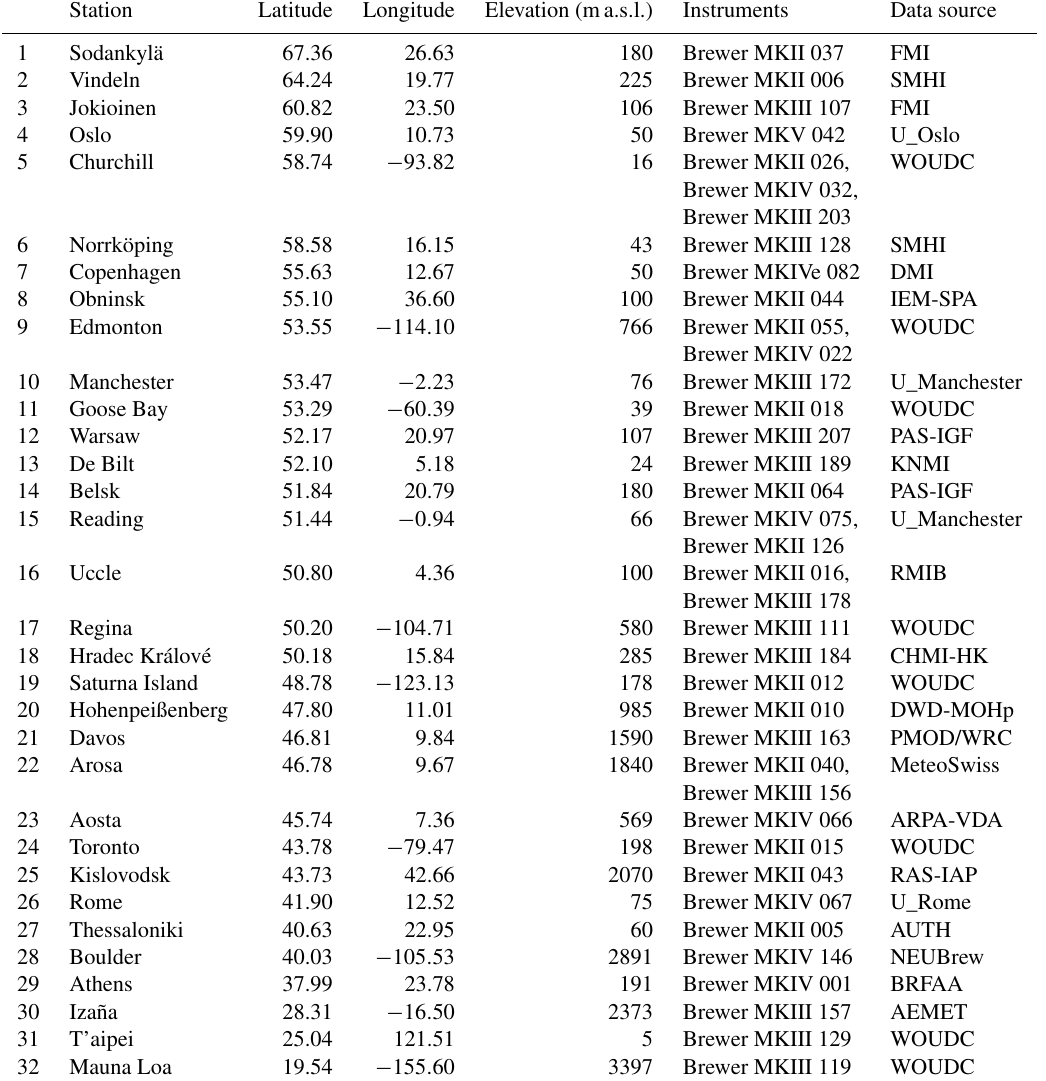
Table 2. Stations with accessible SO 2 column data from Brewers analysed in this study. Stations are sorted from high to lower northern